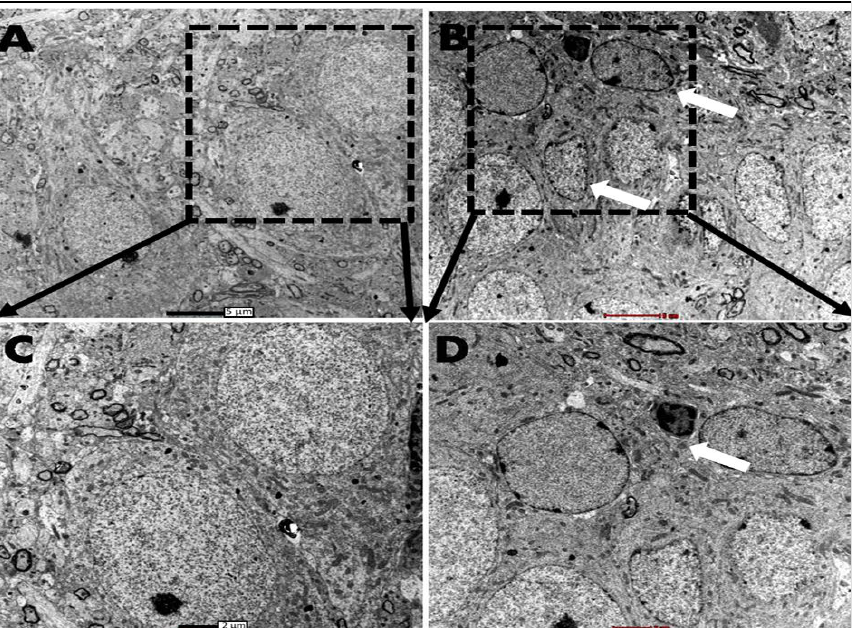
after three days of surgery in both groups (results are not shown). bar = 2 µ m. Three independent sections per brain were examined (n = 3 in each group).